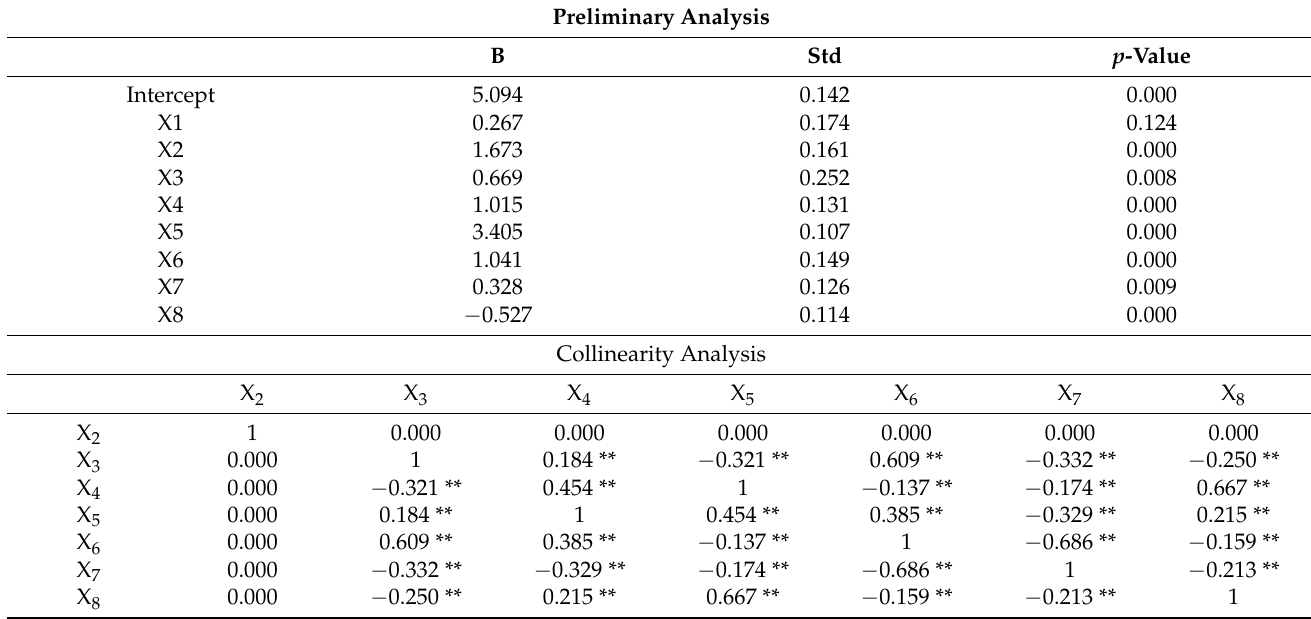
Table 5. Preliminary and collinearity analyses.